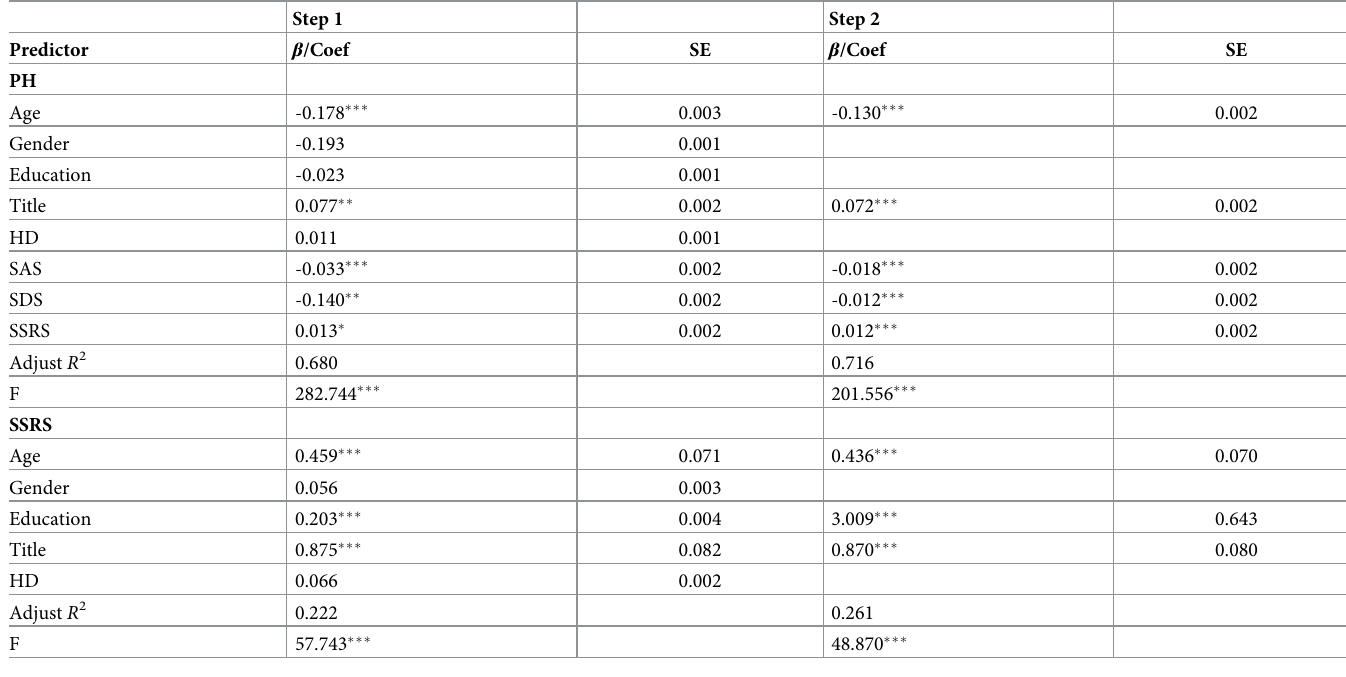
Table 3. Prediction of PH and SSRS.